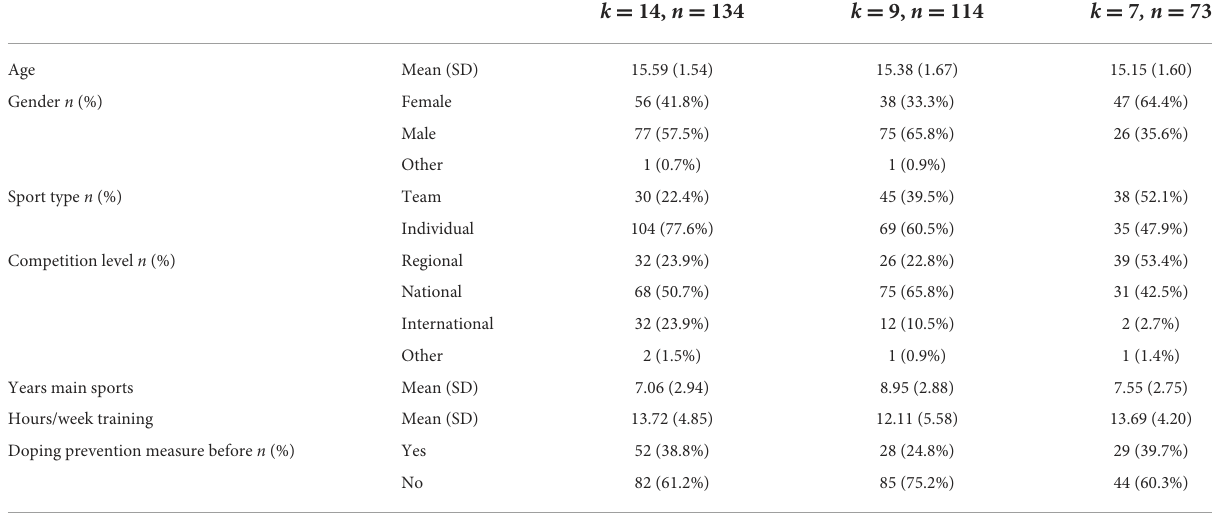
TABLE 1 Participant